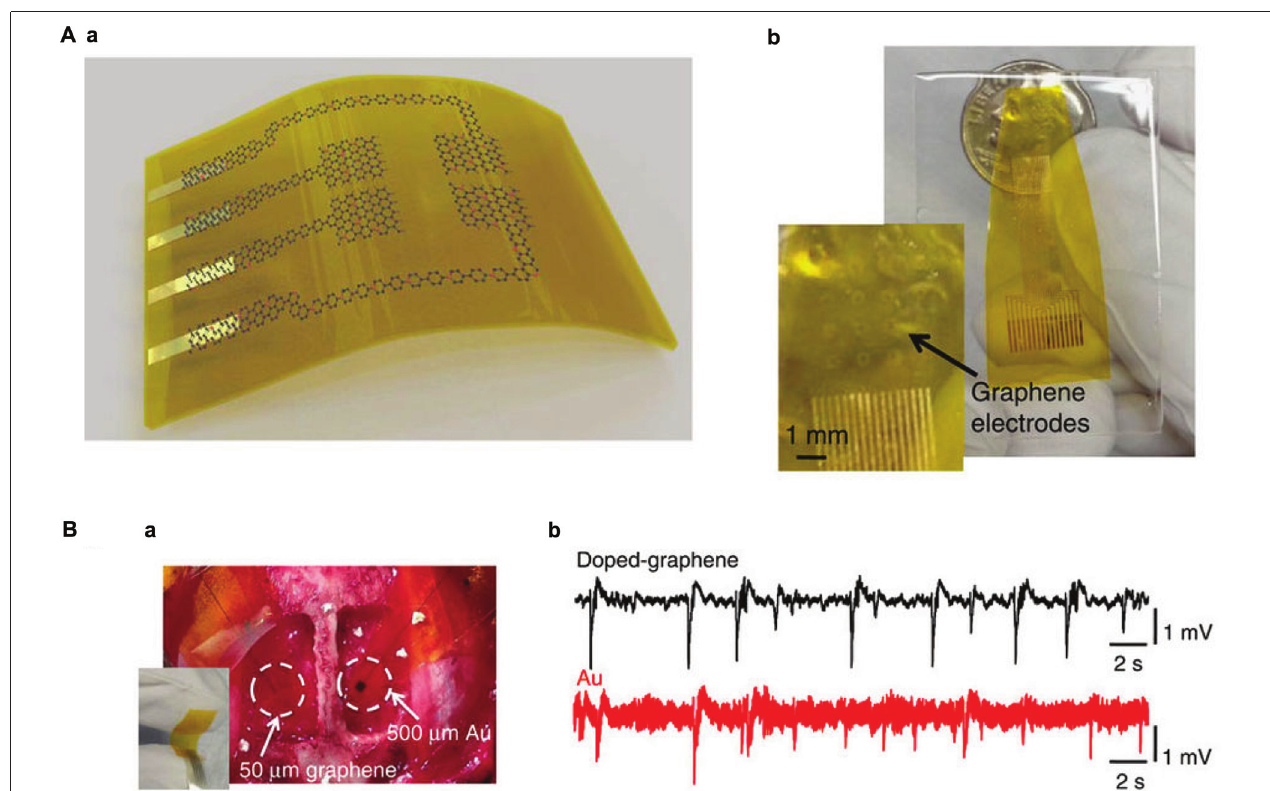
FIGURE 5 | Graphene electrodes for in vivo recording. (A) (a) Schematic illustration of a flexible G neural electrode array. (b) Photograph of a 16-electrode transparent array. The electrode size is 300 × 300 µ m 2 . (B) (a) Photograph of a 50 × 50 µ m 2 single-G electrode placed on the cortical surface of the left hemisphere and a 500 × 500 µ m 2 single-Au electrode placed on the cortical surface of the right hemisphere. (b) Interictal-like spiking activity recorded by 50 × 50 µ m 2 doped-G and Au electrodes. Recordings with doped-G electrodes are five- to sixfold less noisy compared with the ones with same size Au electrode. Modified with permission from Kuzum et al.